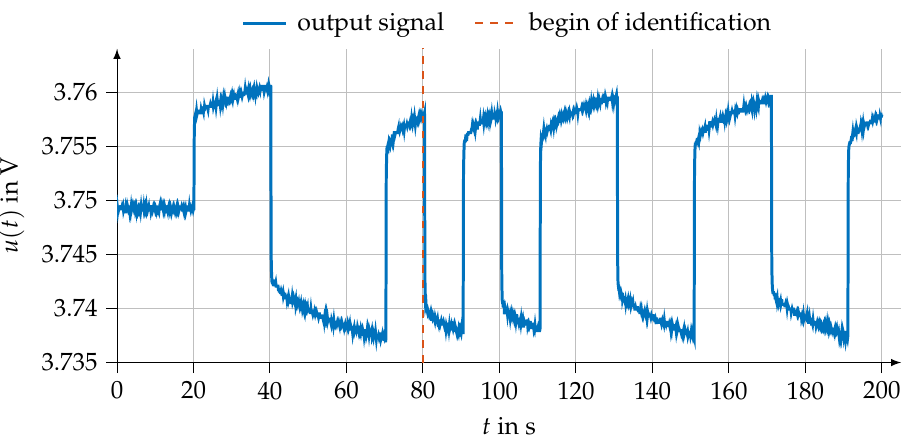
Figure 6. Output voltage measured with the DS2004 High-Speed A/D Board and used as the output signal for the parameter and order identification of the fractional battery model